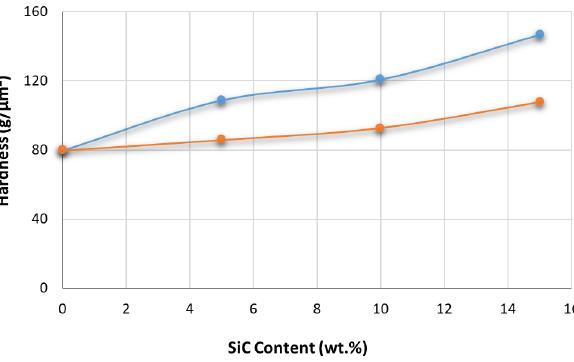
Figure 8: The values of composite hardness for various SiC percent- age at (300 and 400) Mpa compacting pressure